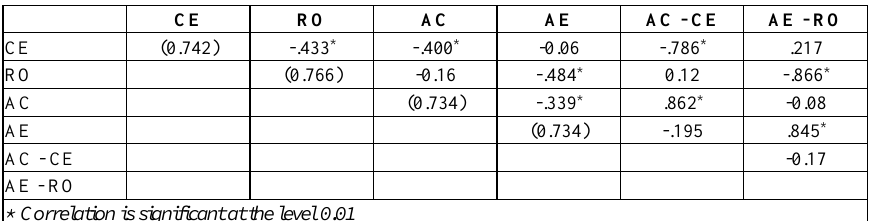
Table 5. Coefficient alpha reliability and scale intercorrelations